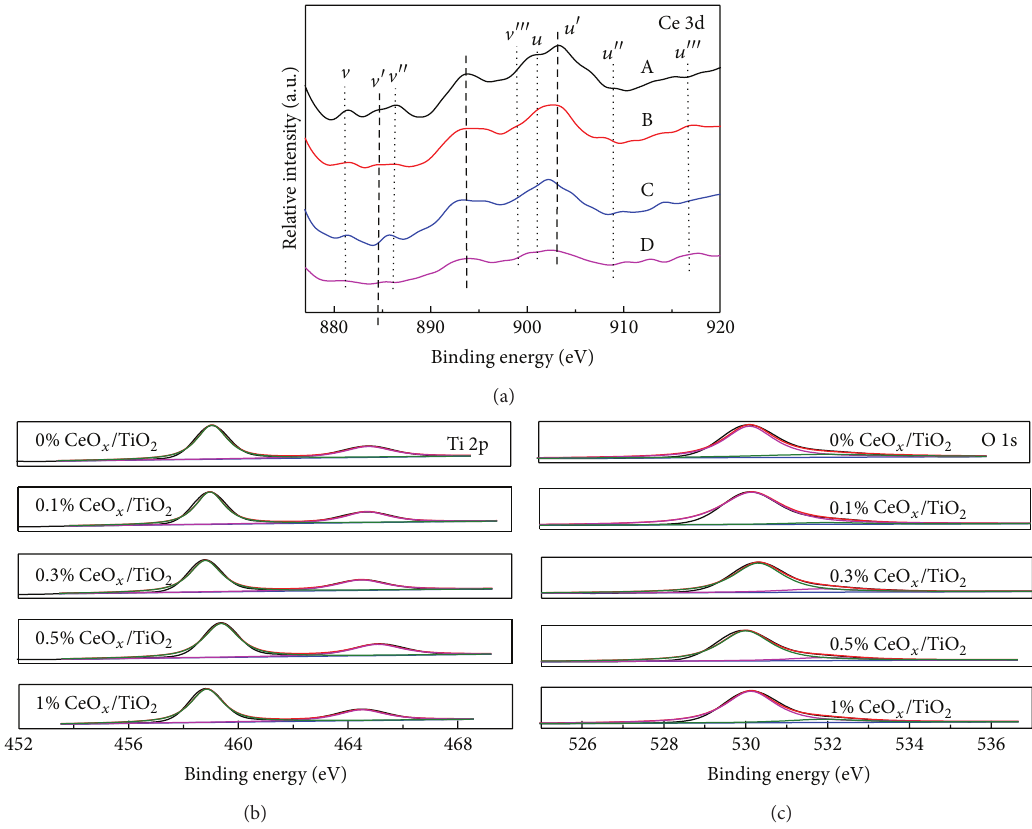
Figure 2: XPS spectra of 𝑥 % CeO 𝑥 /TiO 2 nanoparticles (a) Ce 3d: (A) 1% CeO 𝑥 /TiO 2 , (B) 0.5% CeO 𝑥 /TiO 2 , (C) 0.3% CeO 𝑥 /TiO 2 , and (D) 0.1% CeO 𝑥 /TiO 2 ; (b) Ti 2p; (c) O